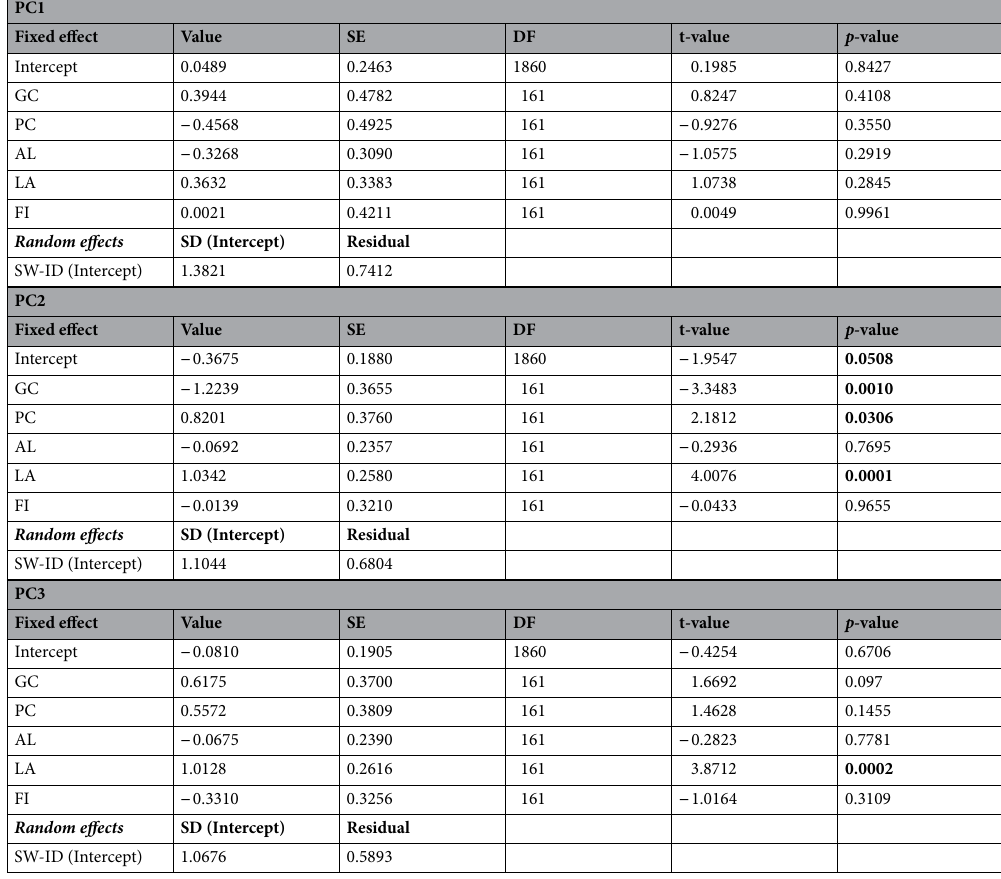
Table 2. Generalized linear mixed-effect model (GLMM) with ‘site’ as explanatory variable on PC1, PC2 and PC3. The upper section shows the significant effects of the assessed explanatory variables. Value, standard errors (SE), t-values, and significance level ( p -value) for variables retained in the model are provided for fixed effects (explanatory variables), while estimates of the standard deviations (SD) are reported for random effects (SW-ID). Significant level in